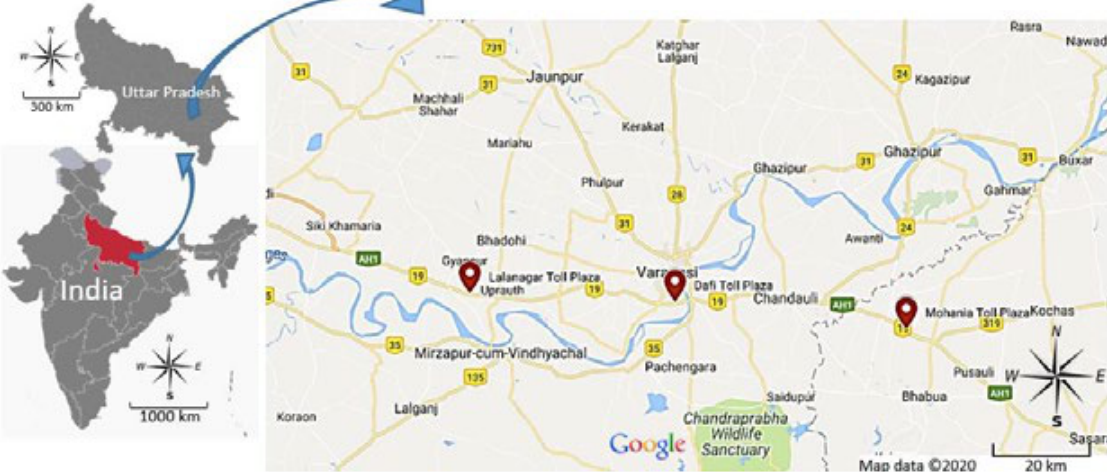
Fig. 1: Geographic location of the study area along with the selected road toll booths for data and sample collection